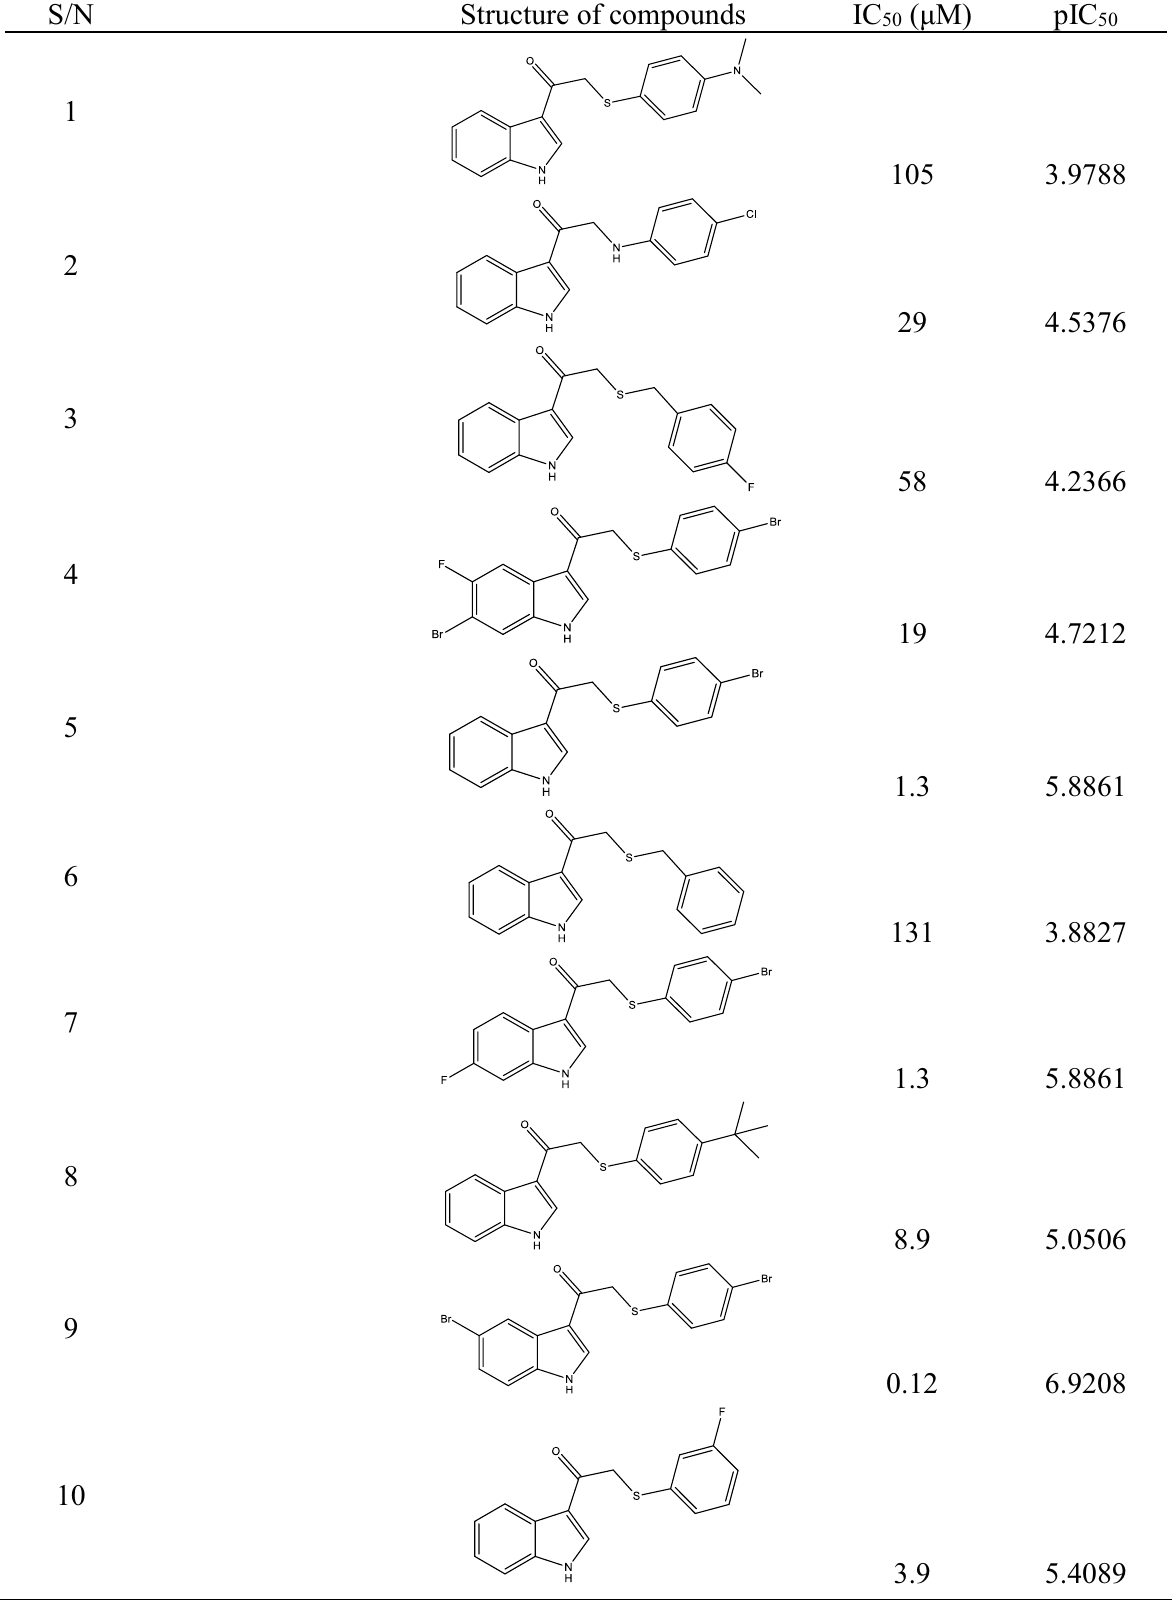
Table 1 Molecular structures of indolyl-3-ethanone-α-thioethers derivatives and their biological activities against P. falciparum strain